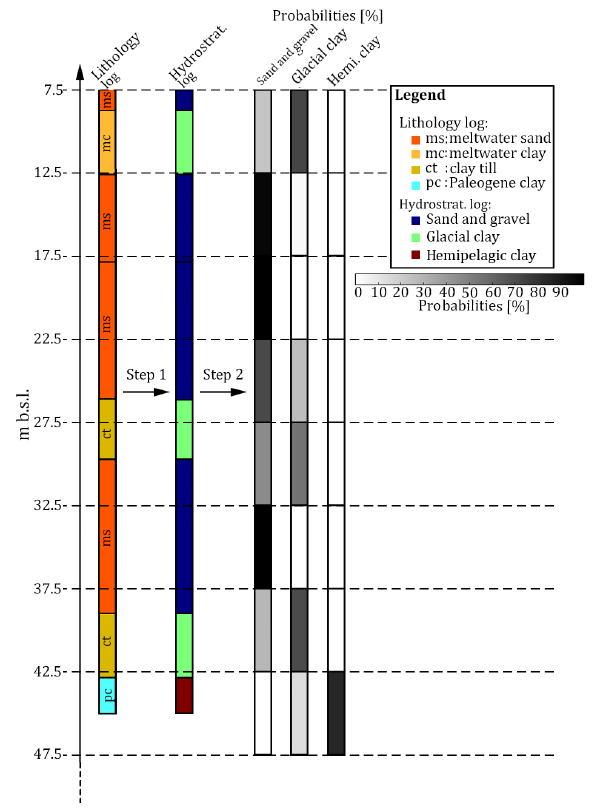
Figure 3. A schematic diagram presenting the conversion of the lithological logs into probability logs for the three hydrostrati- graphic units: sand and gravel, glacial clay, and hemipelagic clay. Step 1: the lithology log is translated into a hydrostratigraphic log. Step 2: the hydrostratigraphic logs are resampled according to the vertical modeling grid intervals and an interval probability is calcu- lated for each of the hydrostratigraphic